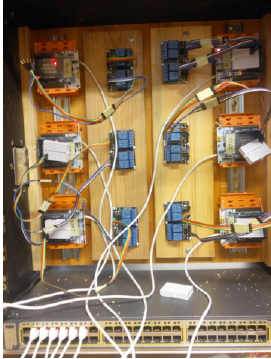
Figure 5. Experiment setup.